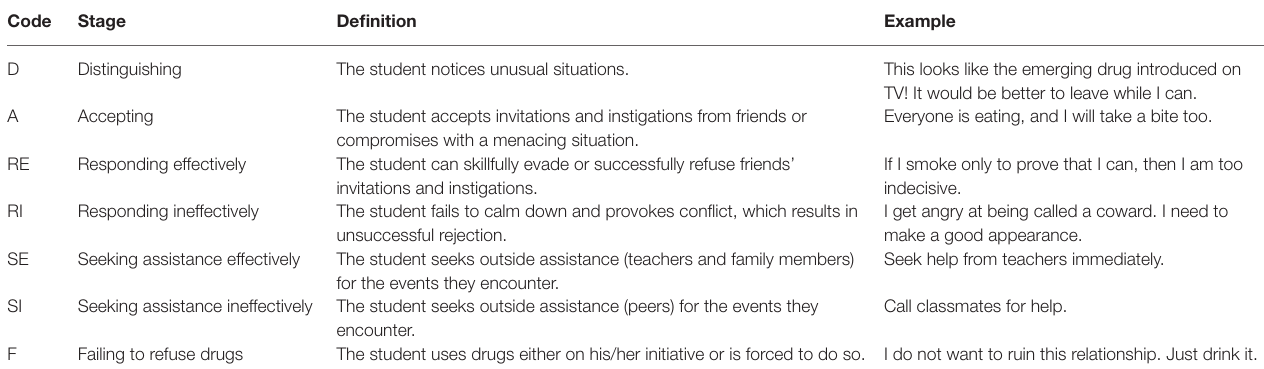
TABLE 2 | Coding table of the